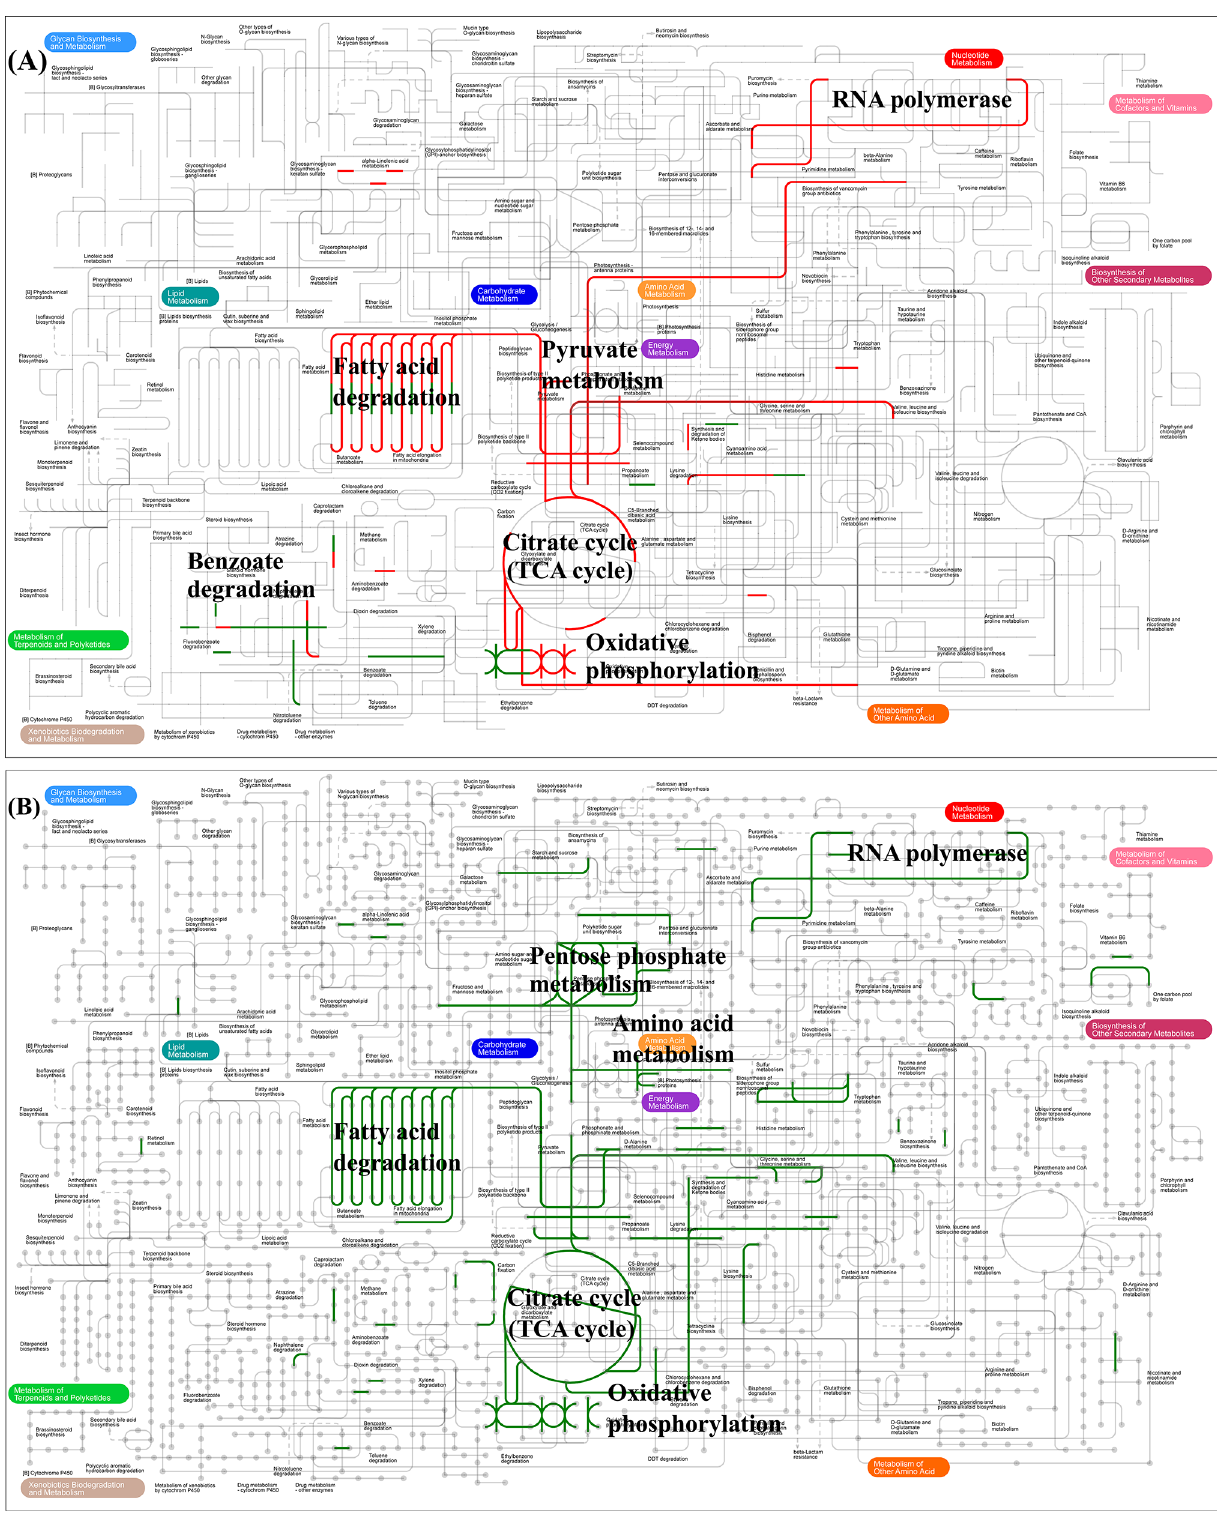
Fig 5. Metabolic pathway maps of the selected differentially expressed genes in Rhodococcus sp. strains TG13 (A) and TN3 (B). The red and the green lines indicate genes with up-regulated and down-regulated, respectively.